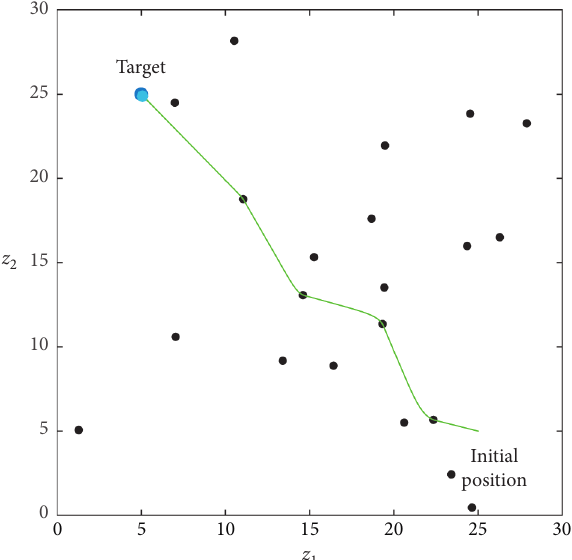
Figure 4: Landmark navigation of the 2D point robot with initial position ( 25 , 5 ) and the target placed at ( 5 , 25 ) .